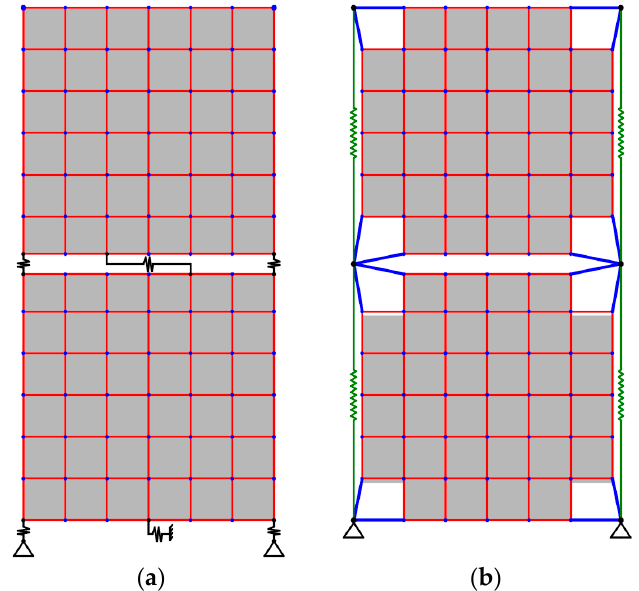
Figure 5. Finite element (FE) representation of shear wall: ( a ) type A systems; ( b ) type B systems.